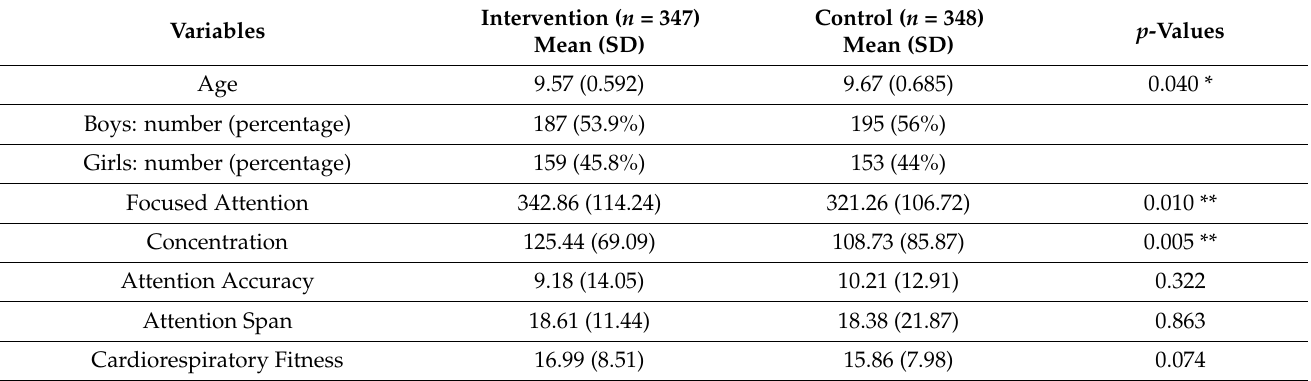
Table 1. Baseline characteristics of participants by group.